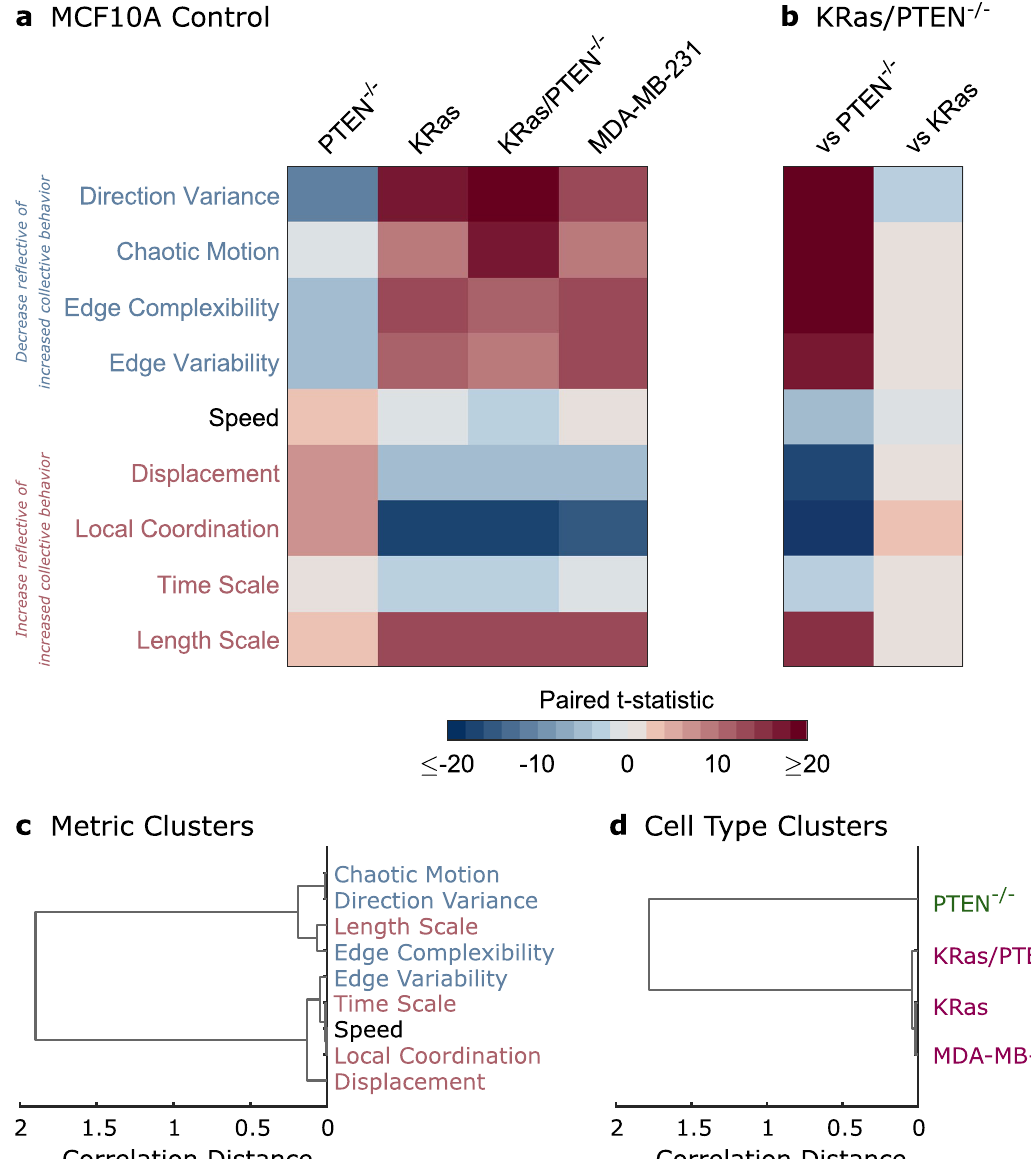
Figure 4. Activated KRas dominates the collective migration phenotype. ( a ) Multidimensional phenotype for four cell lines as compared to the MCF10A control. The strength of changes in metrics are indicated by color representing the paired t-statistic (see Supplementary Fig. S7). ( b ) Migration phenotypes comparing the KRas/ PTEN −/− cells to the single mutant cell lines. ( c ) Clustering of migration metrics using correlation distance. ( d ) Clustering of cell lines using correlation